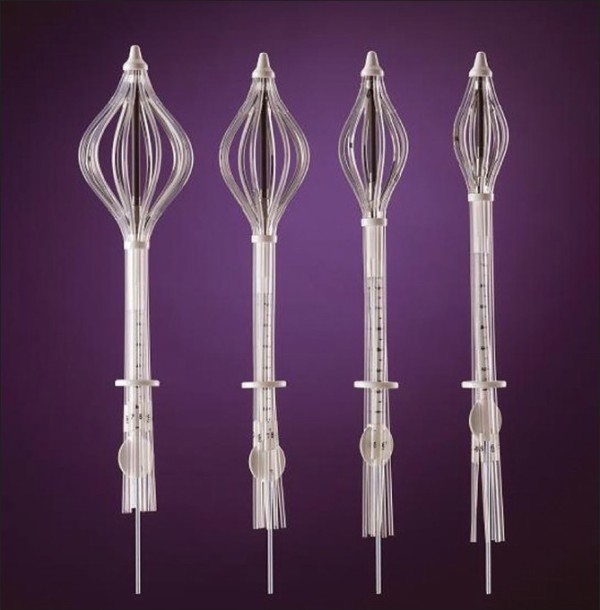
Different sizes of SAVI with peripheral struts expanded (courtesy of Cianna Medical).